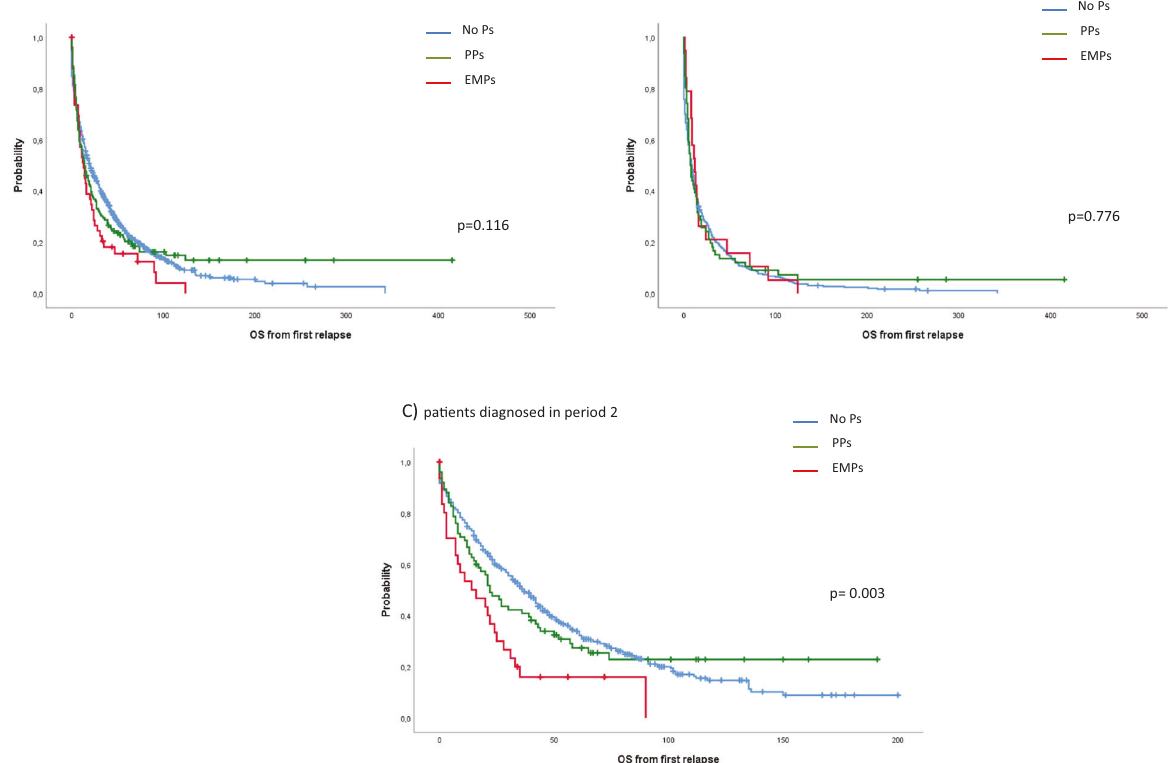
Fig. 3 Overall survival from fi rst relapse. A Overall series, B patients diagnosed in period 1, and C patients diagnosed in period